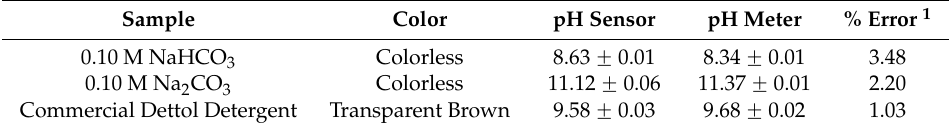
Table 2. pH detection for different samples using the optical pH sensor compared with a commercial pH